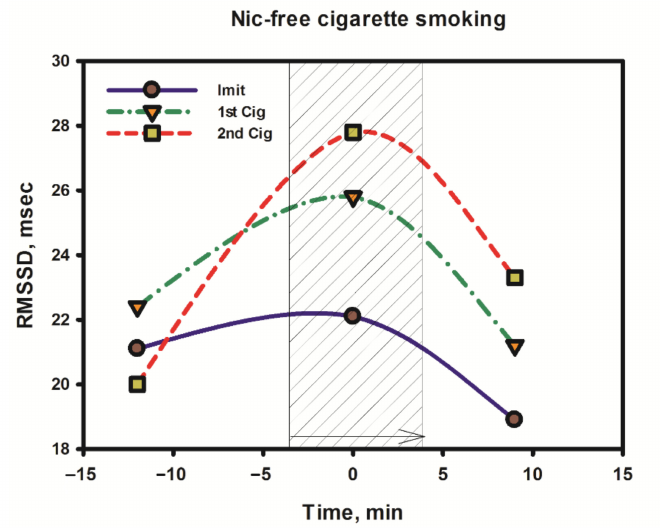
Figure 2. Increase in parasympathetic activity in a volunteer when smoking two